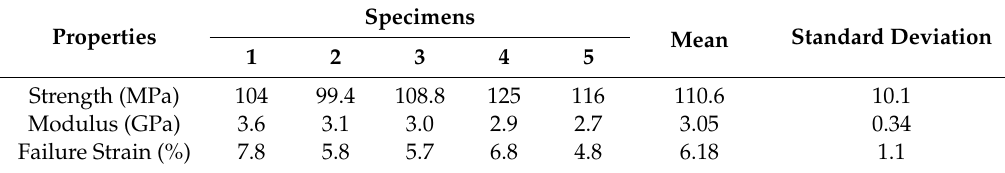
Table 5. Tensile properties of multi-angled 3D-printed GFRP composite specimens (Set